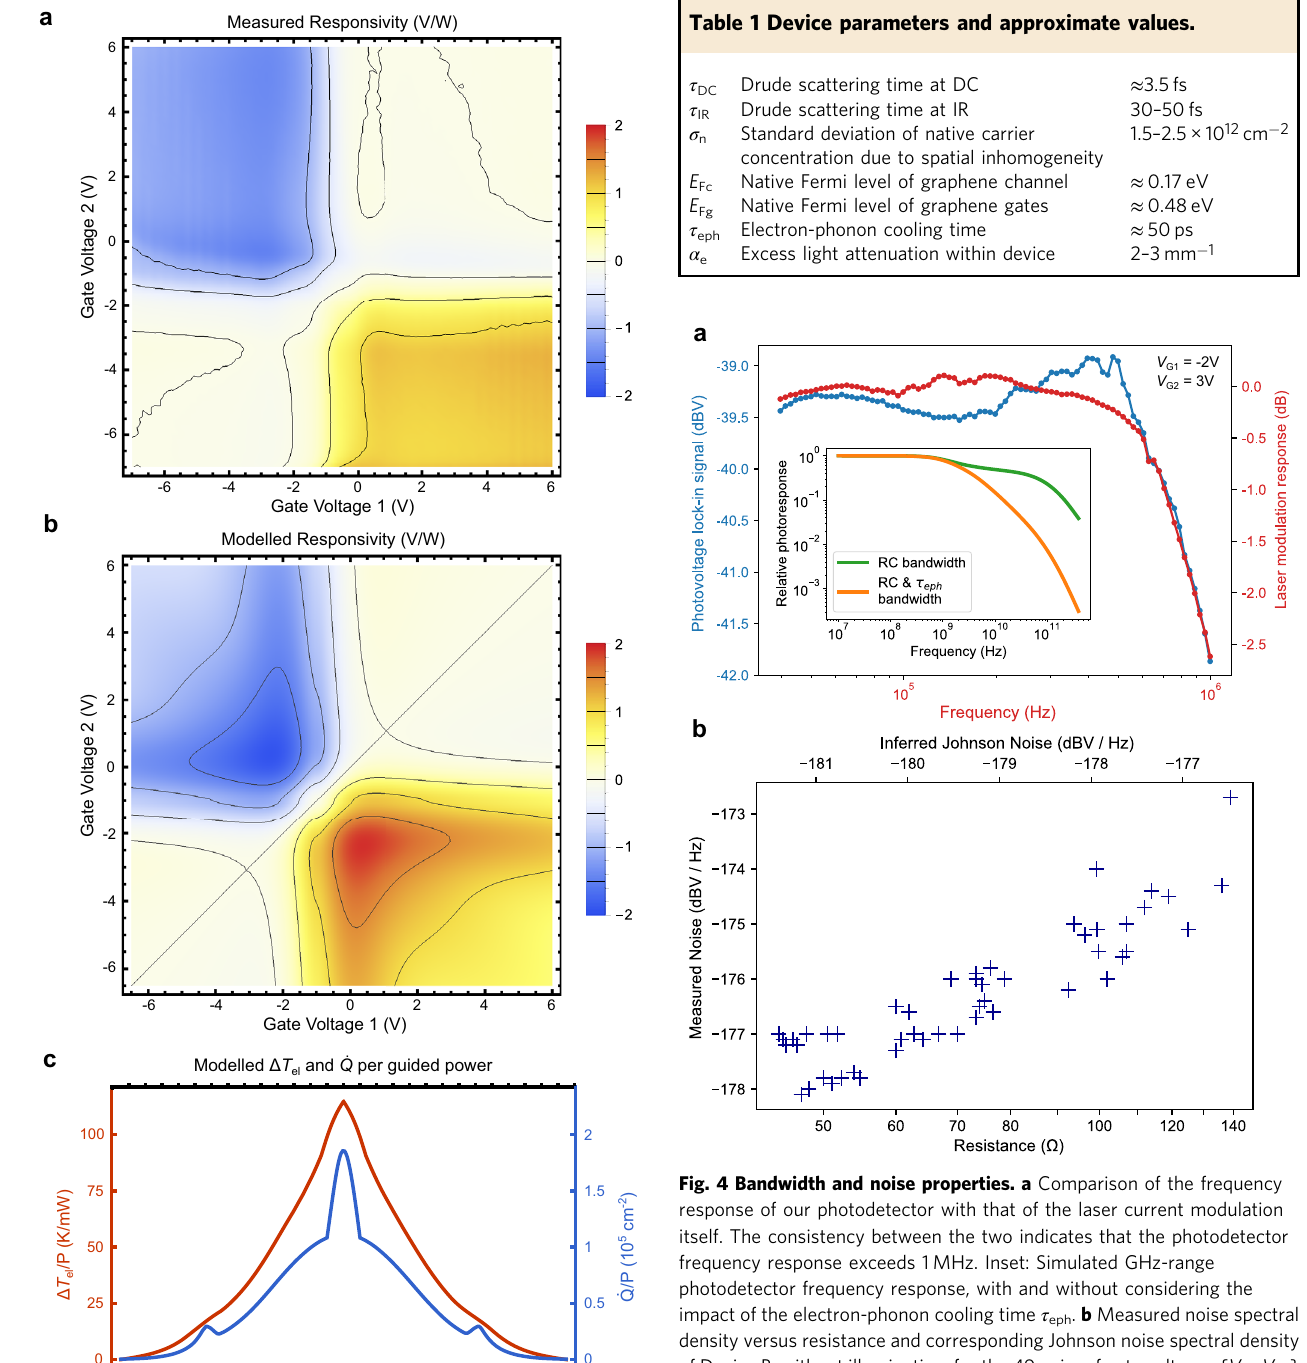
Table 1 Device parameters and approximate values.